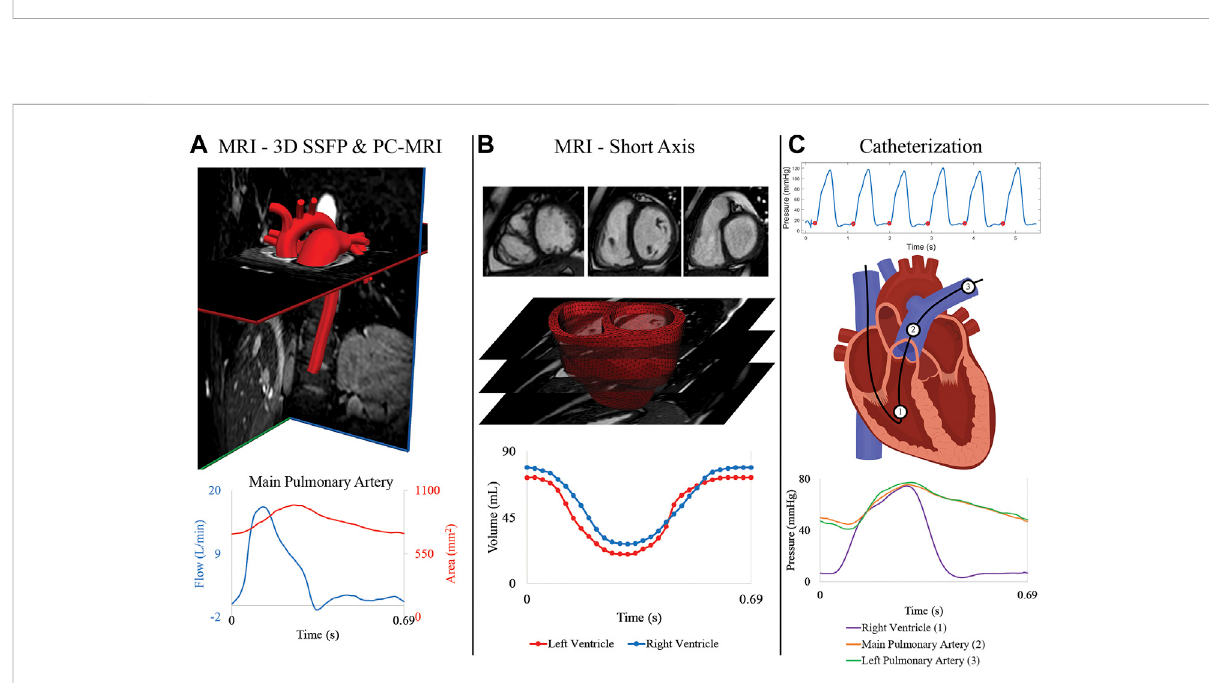
FIGURE 2 (A) MRI 3D SSFP data is used to construct the anatomical arterial models. Flow and area waveforms were reconstructed from PC-MRI data containing 40 phases. (B) 30 temporal phases of endocardial and epicardial surfaces were segmented from the short-axis stack of cine MRI data to generate the ventricular volume waveforms. High-resolution (3D) ventricular models were created from these segmented surfaces. (C) Pressures at the (1) right ventricle, (2) main pulmonary artery, and (3) right pulmonary artery were acquired with catheterization for all